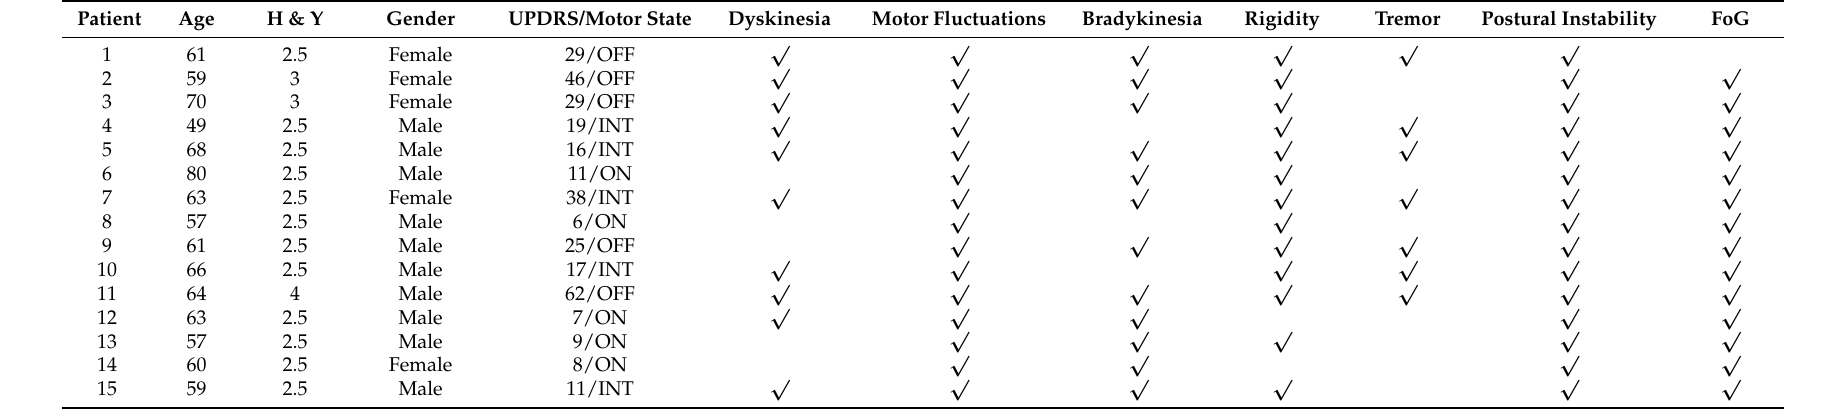
Table 2. Demographics and PD symptoms of the patients included in the